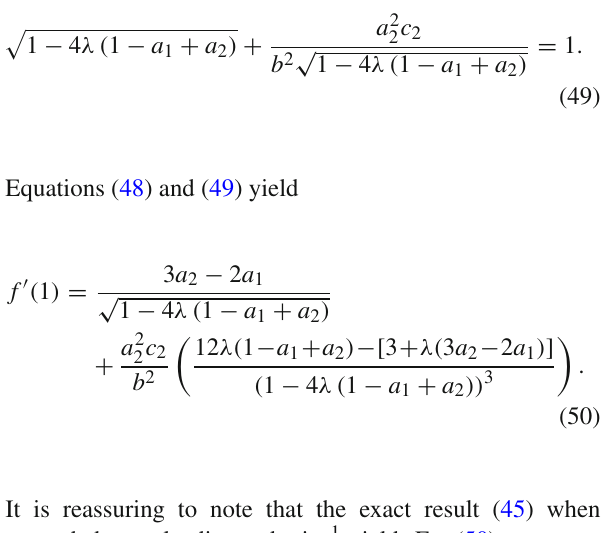
Defining a new parameter